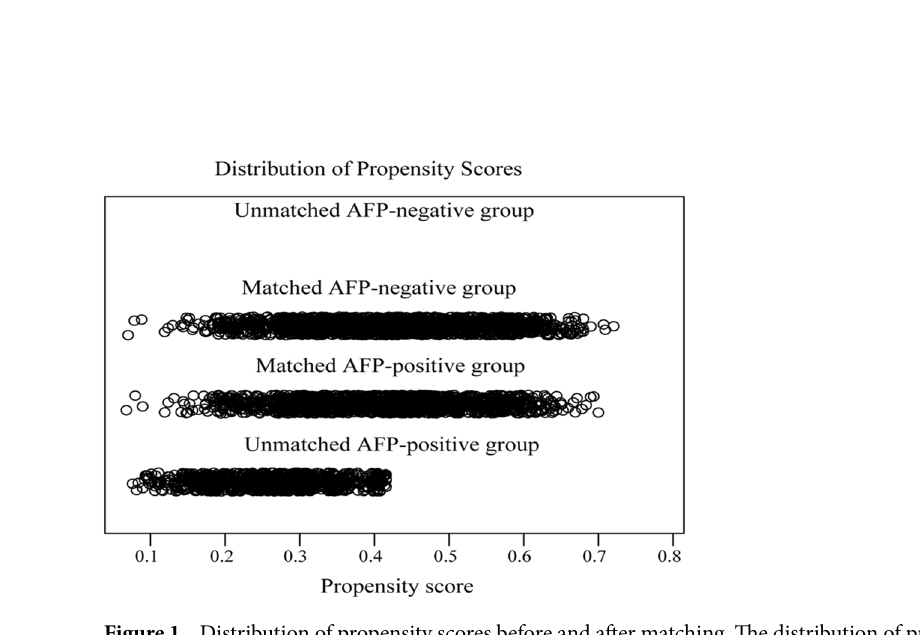
Figure 1. Distribution of propensity scores before and after matching. The distribution of propensity scores of matched patients between groups were